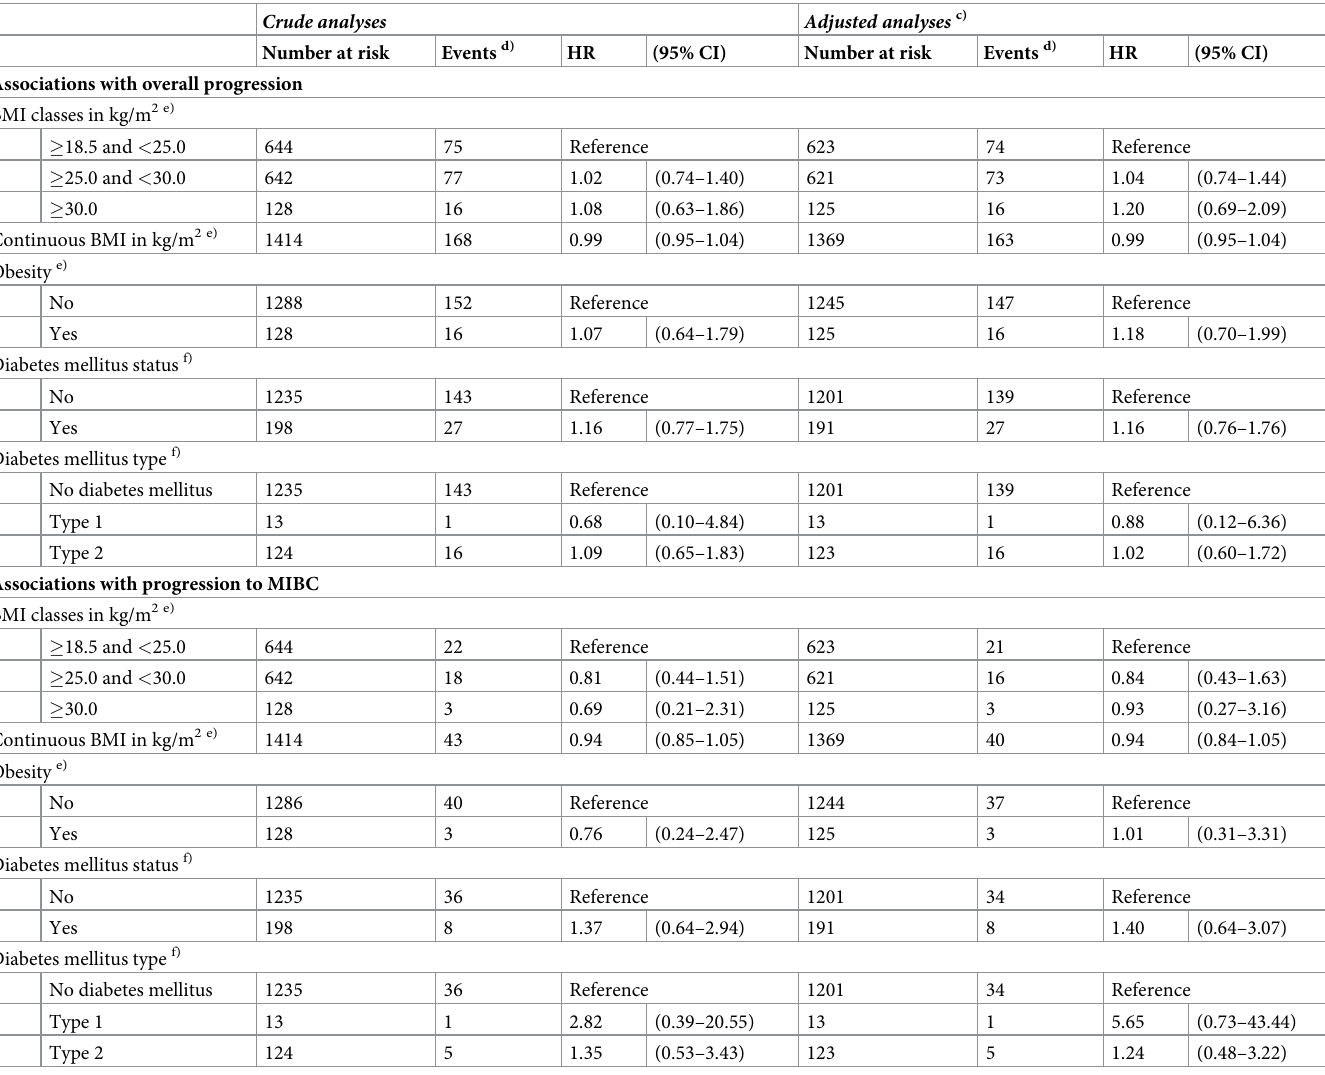
Table 3. Crude and adjusted hazard ratios (HR) with corresponding 95% confidence intervals (CI) for the associations of adult BMI and diabetes mellitus with overall progression a) and progression to Muscle Invasive Bladder Cancer (MIBC) b) among non-muscle invasive bladder cancer